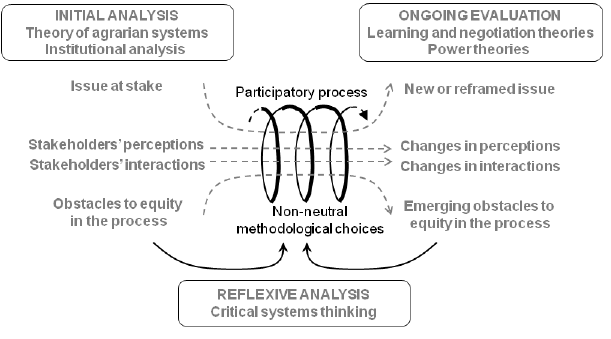
Fig. 1 . Framework of a ComMod process conducted with critical companion